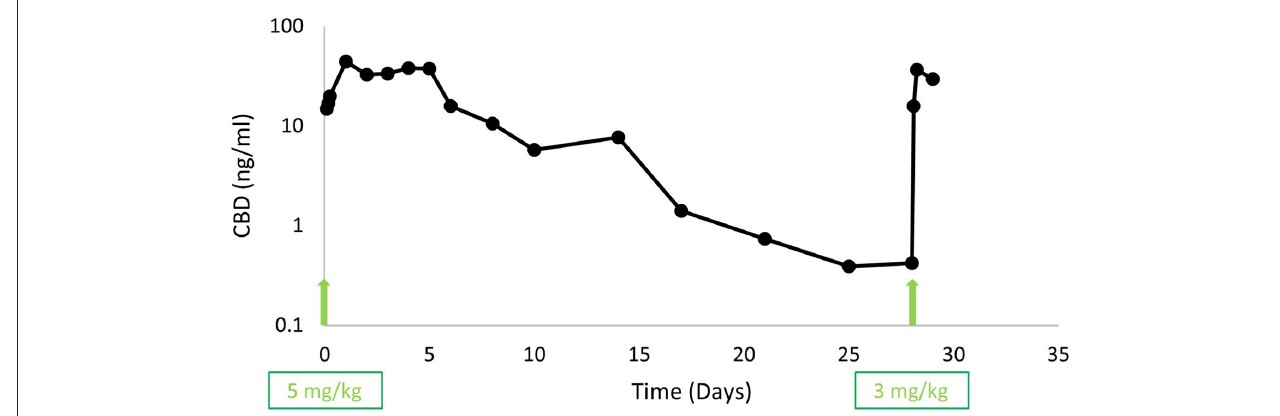
FIGURE 2 | Plasma cannabidiol (CBD) concentrations (ng/mL) in a 14-year-old dog suffering from bilateral hip and elbow osteoarthritis and severe neck pain. The arrows indicate subcutaneous liposomal CBD injections that were performed on days 0 (5 mg/kg) and 28 (3